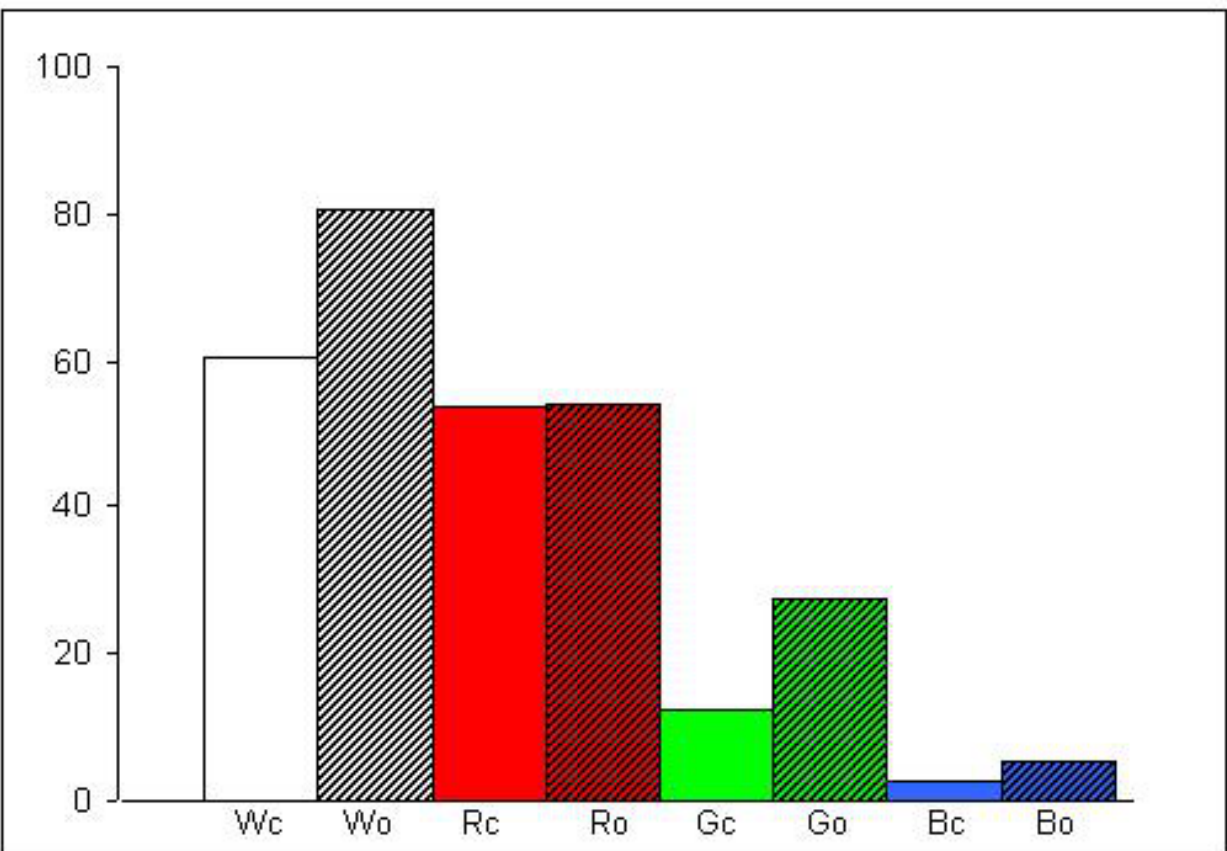
Fig. 5. Percentage of bird (groups) responding to different light conditions: white (W), red (R), green (G), and blue (B) under clear (c) and overcast (o) conditions during our observation